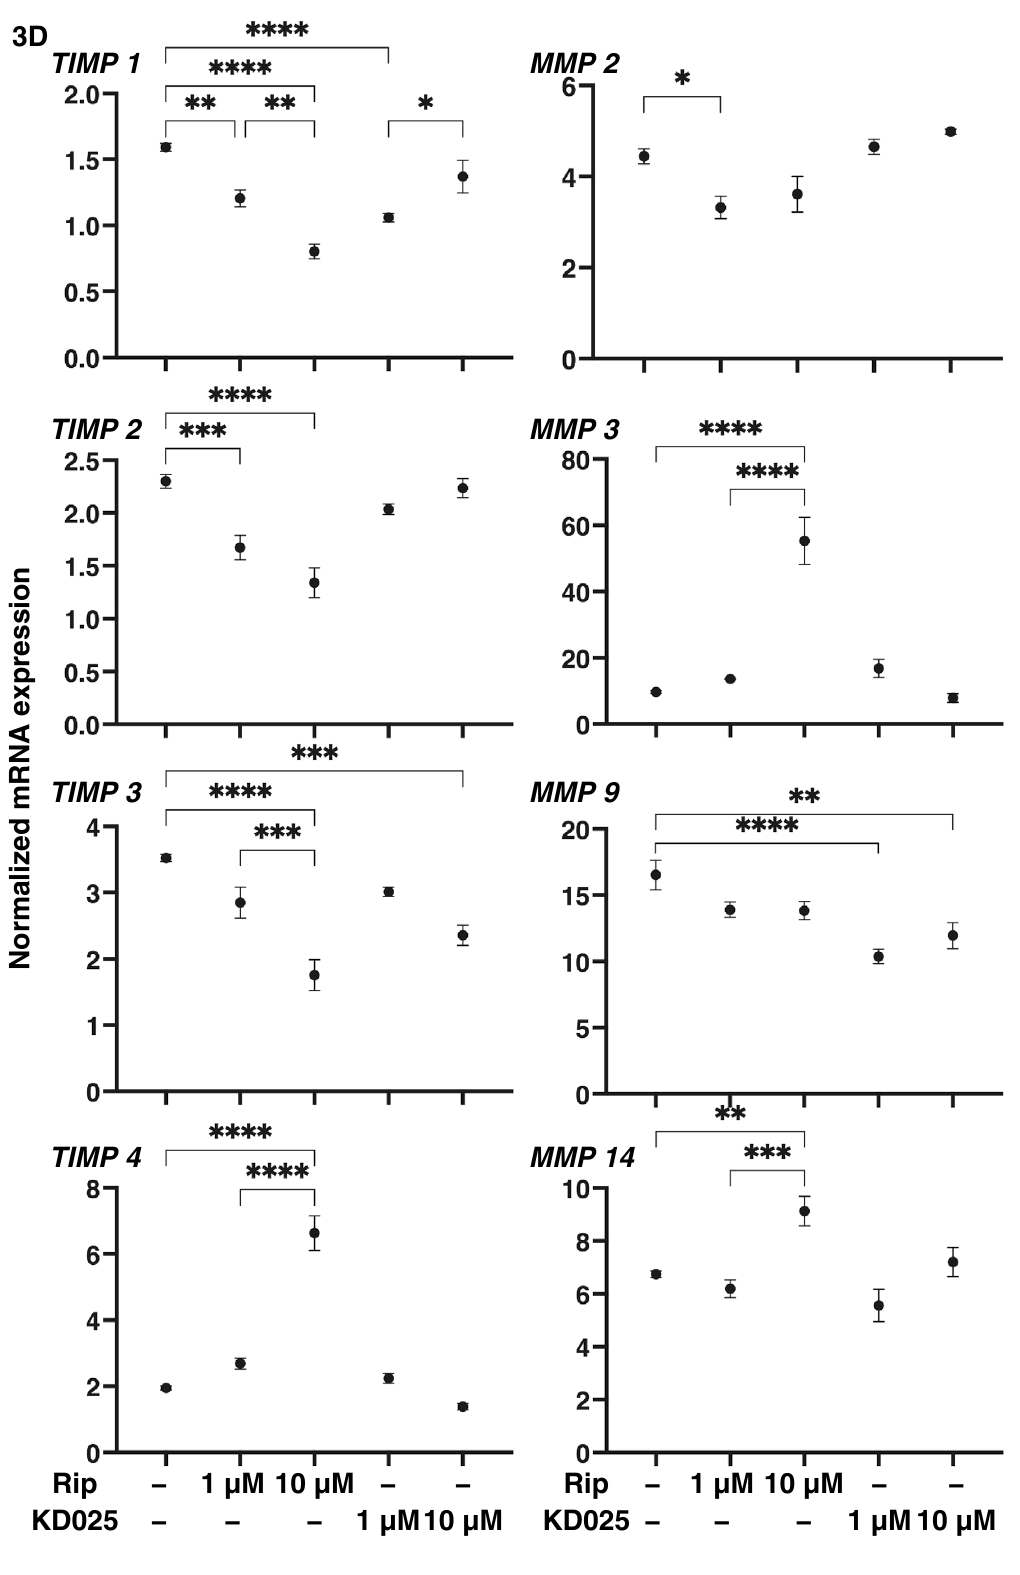
Figure 5. Effects of ROCK-is on the mRNA expression of TIMPs (1–4) and MMPs (2, 3, 9, 14) in 3D spheroids of human corneal stroma fibroblasts (HCSFs). In the absence or presence of 1 μM or 10 μM ROCK-is, ripasudil (Rip) or KD025, 3D HCSFs spheroids at Day 6 were subjected to qPCR analyses and the mRNA expression of TIMPs (1–4) and MMPs (2, 3, 9, 14) was estimated. All experiments were performed in duplicate using fresh preparations (n = 10–15, each). Data are presented as the arithmetic mean ± standard error of the mean (SEM). * P < 0.05, ** P < 0.01, *** P < 0.005, *** P < 0.001 (ANOVA followed by a Tukey’s multiple comparison